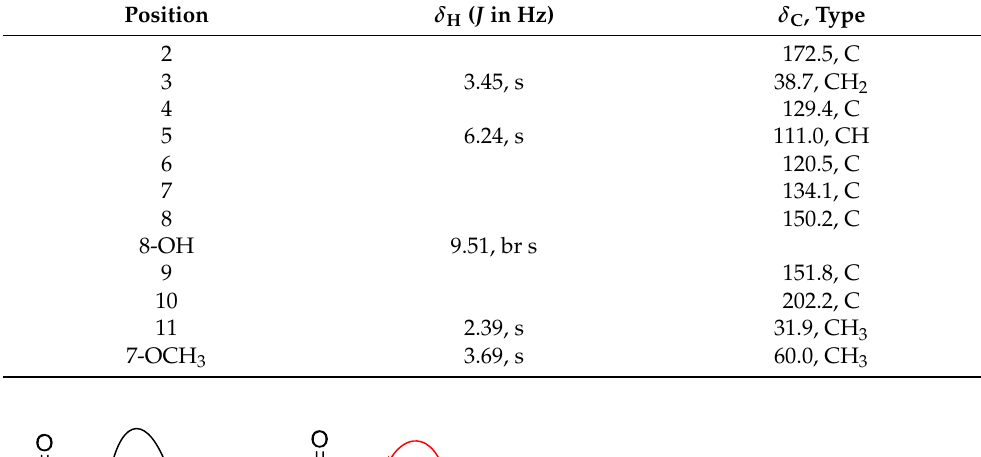
Figure 1. The structures of compounds 1 – 9 . Table 1. 1 H (400 MHz) and 13 C (100 MHz) NMR data for compound 1 (DMSO- d 6 ).